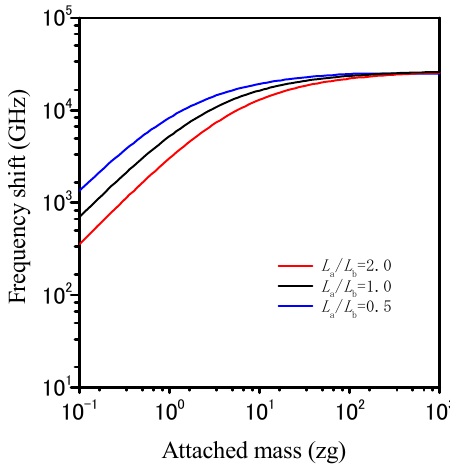
Figure 6. Location effect of the attached nanoparticle on the frequency shift of DLGS resonator ( (cid:1838) 2ℎ = (cid:1838) 2ℎ = 20⁄⁄ ). (cid:3028) (cid:3029)